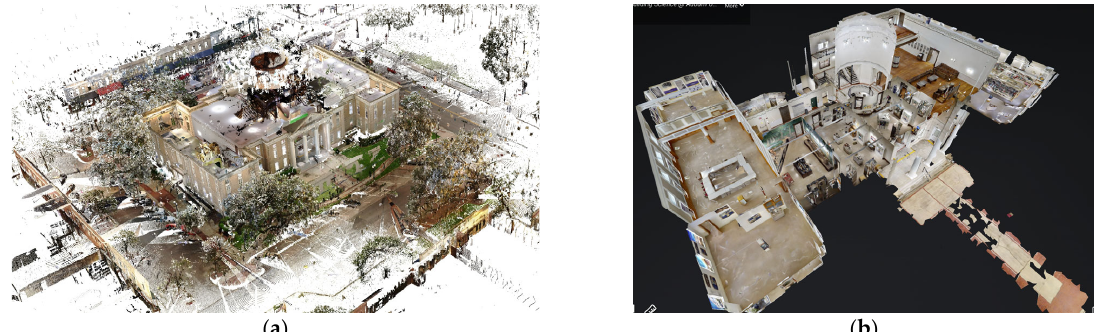
Figure 25. Processed RT data of the OPCC: ( a ) TLS point cloud consisting of approximately 1.8 billion points; ( b ) “doll ‐ house” view of the immersive 3D virtual tour.